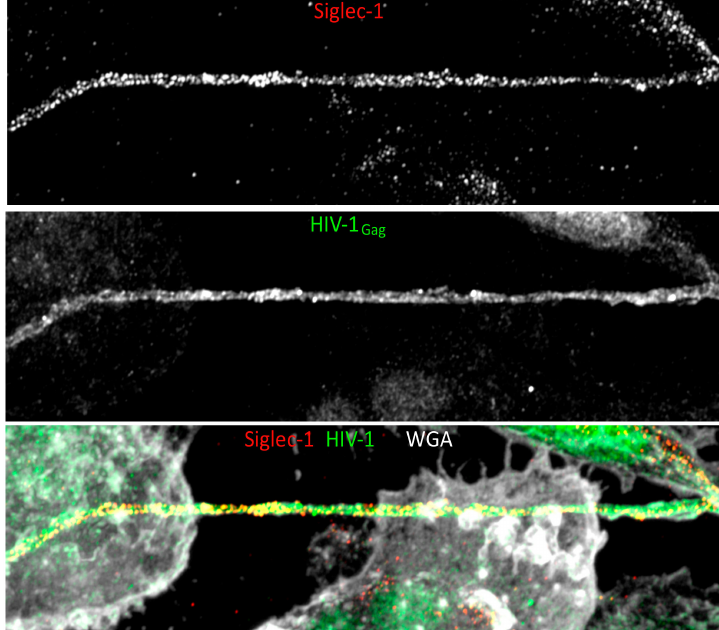
Figure 3. HIV-1 spreads between macrophages through Siglec-1 + tunneling nanotubes (TNT). Primary human monocytes were di ff erentiated for 3 days with supernatant from Mycobacterium tuberculosis - infected MDM, and then infected with HIV-1 NLAD8 -VSVg. Representative immunofluorescence labeling showing HIV + -Siglec-1 + thick TNT (taken from [117] and used under CCBY 4.0). Staining shows extracellular Siglec-1 (top) intracellular HIV-1 Gag (middle), and cell plasma membrane stained with Wheat Germ Agglutinin (WGA, grey) with all 3 colors merged in the lower image. Scale bar: 10 µ